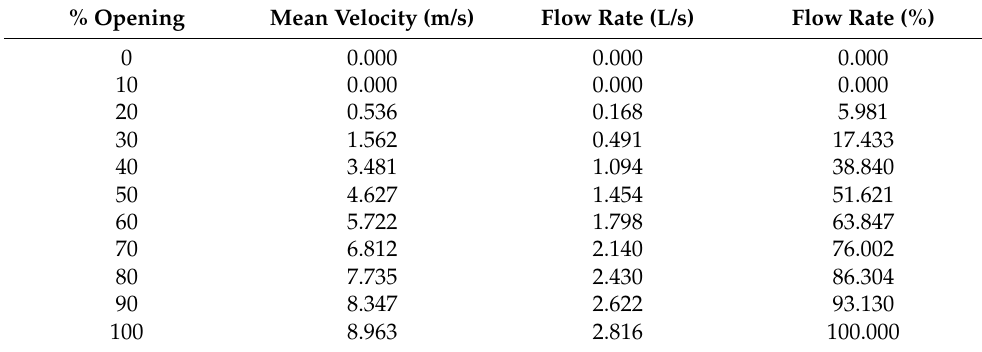
Table 1. First valve geometry: opening percentage x flow rate.